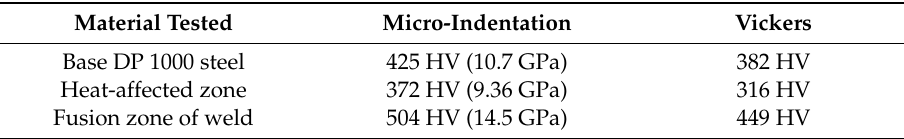
Table 5. Comparison of average measured hardness.